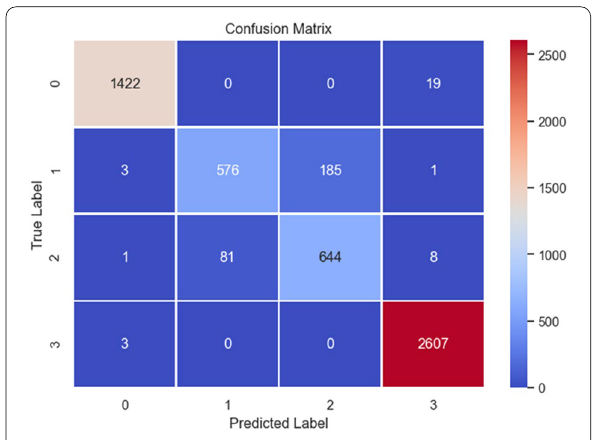
Fig. 9 Confusion matrix of